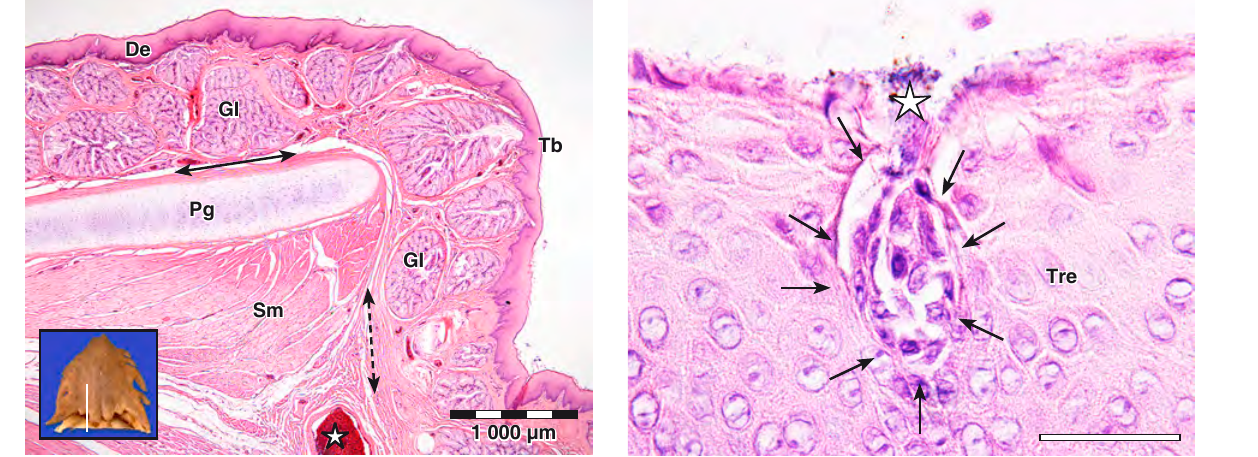
FIG. 13 Enlargement of the area encircled in Fig. 12 showing a structure resembling a taste bud observed on the tongue root close to the glottis. This structure is clearly demarcated (arrows) from the tongue root epithelium (Tre) and is comprised of vertically oriented cells. Putative taste pore (star). Bar = 25 μ m